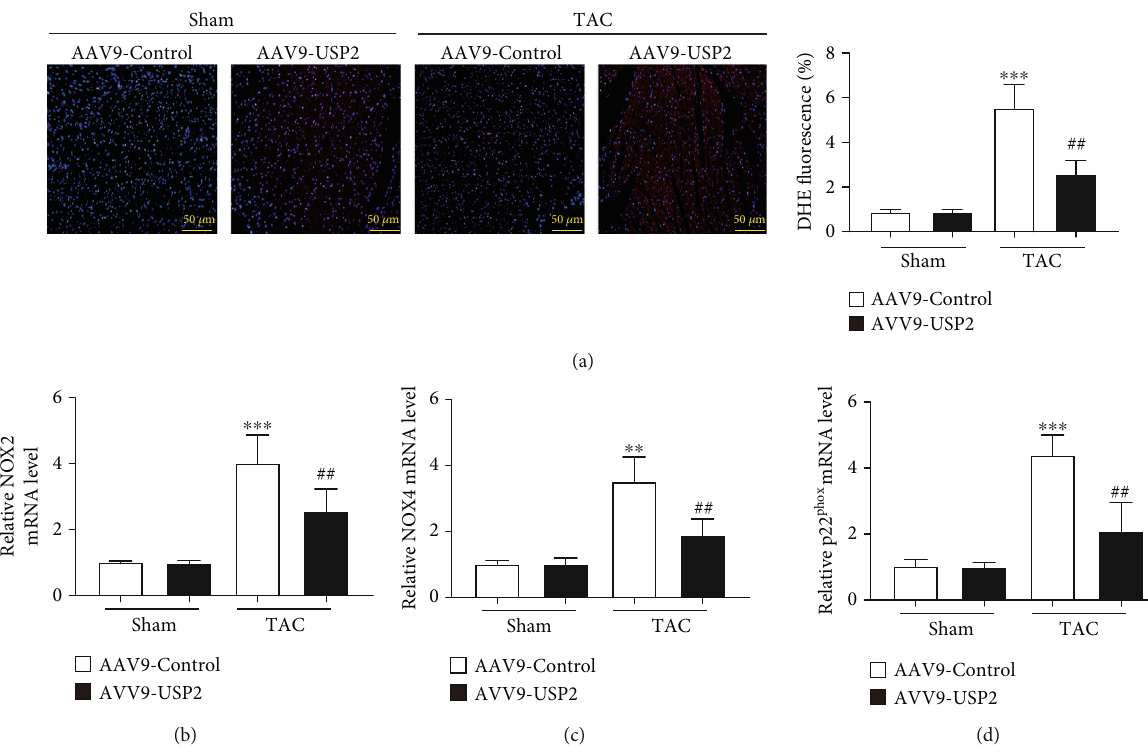
Figure 5: Overexpression of USP2 reduced cardiac oxidative stress in response to pressure overload. (a) Representative images of DHE in the ventricular sections (upper). Quanti fi cation of DHE fl uorescence intensity (lower). (b) qPCR analysis of the mRNA expression of NOX2, NOX4, and p22 phox in heart tissues from AAV9-Control or AAV9-USP2-treated mice following sham or TAC. All values are presented as the relative value of the sham (AAV9-Control) value. ∗ P < 0 : 05 and ∗∗ P < 0 : 01 (AAV9-Control plus TAC vs. AAV9-Control plus sham); # P < 0 : 05 and ## P < 0 : 01 (AAV9-Control plus TAC vs . AAV9-USP2 plus TAC). n = 6